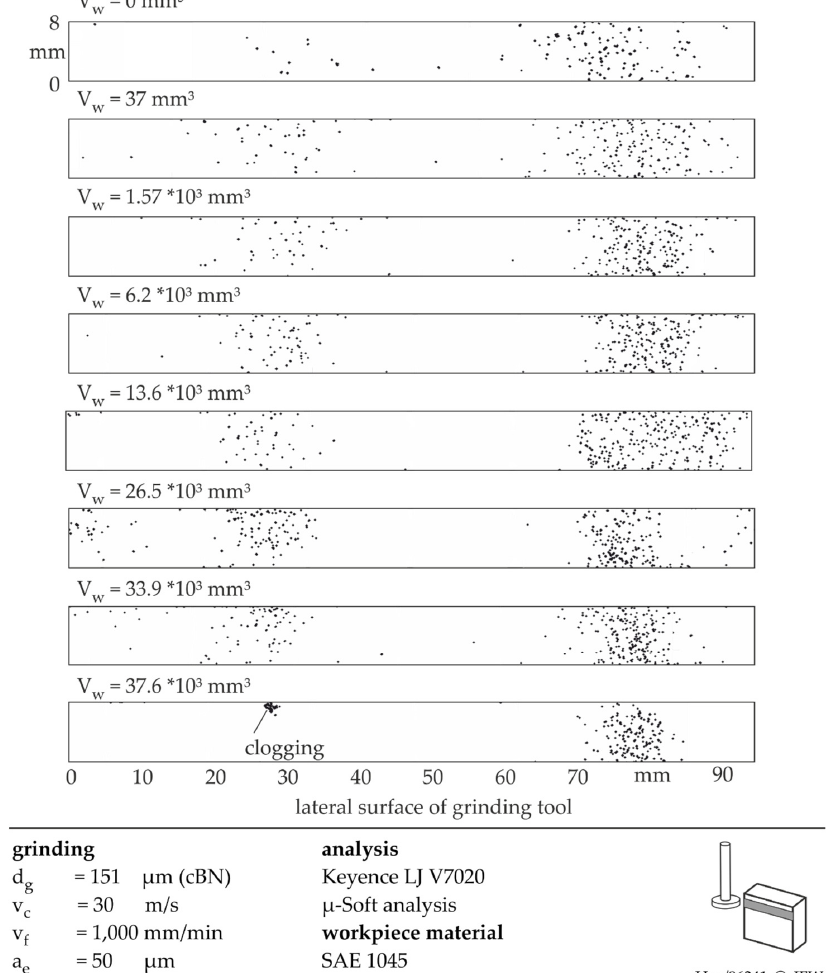
Figure 6. Surface-generating tool points.